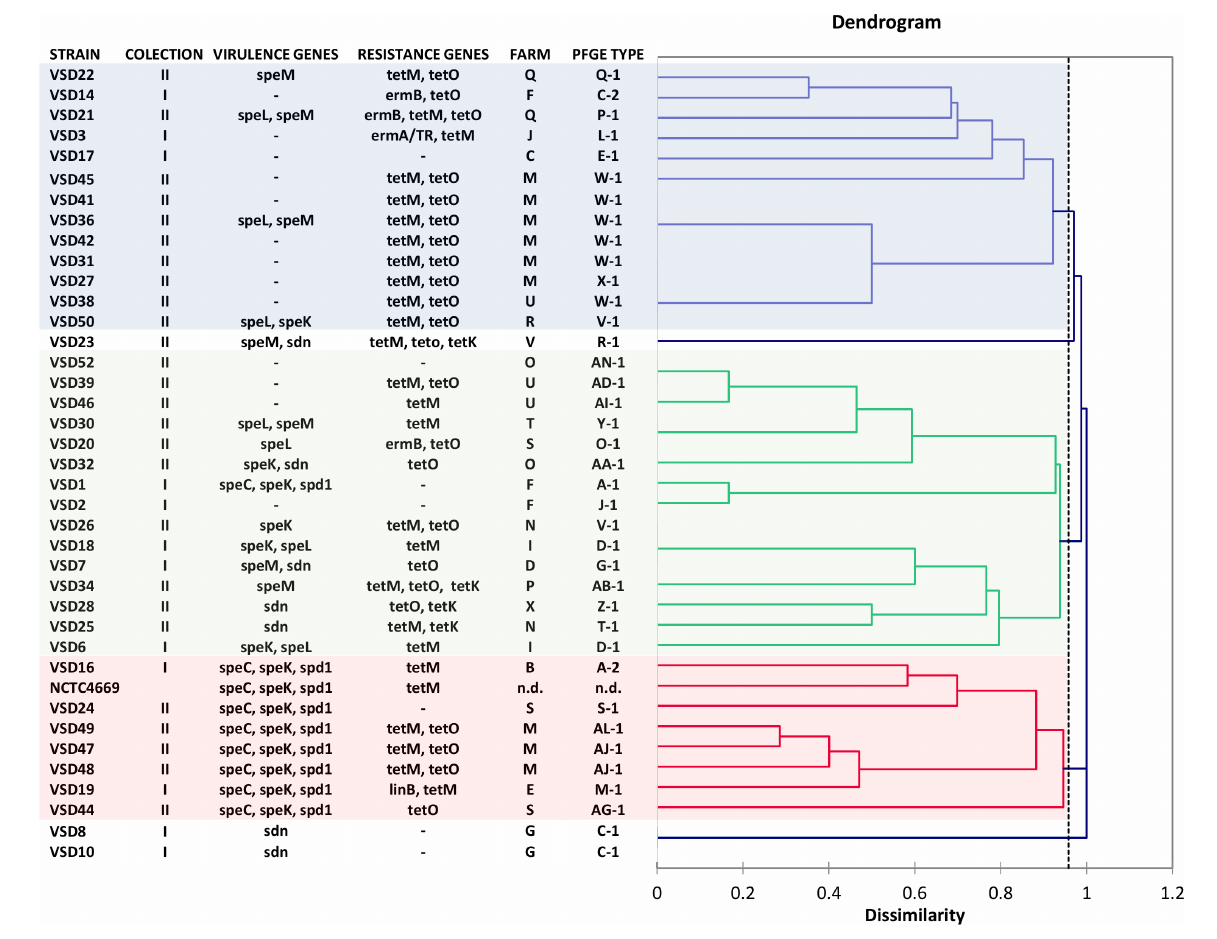
FIGURE 5 | Dendrogram based on spacer CRISPR IIA cluster of Streptococcus dysgalactiae subsp. dysgalactiae isolates of mastitis in cattle collected in 2002–2003 (Rato et al., 2010, 2011, 2013) (VSD1 to VSD19—collection I) and 2011–2013 (VSD20 to VSD56—collection II). Streptococcus pyogenes phages encode genes speC , speK , speL , speM , spd1 , and sdn . The dendrogram was obtained by means of Dice coefficient and the agglomerative clustering of the unweighted pair group method with arithmetic mean